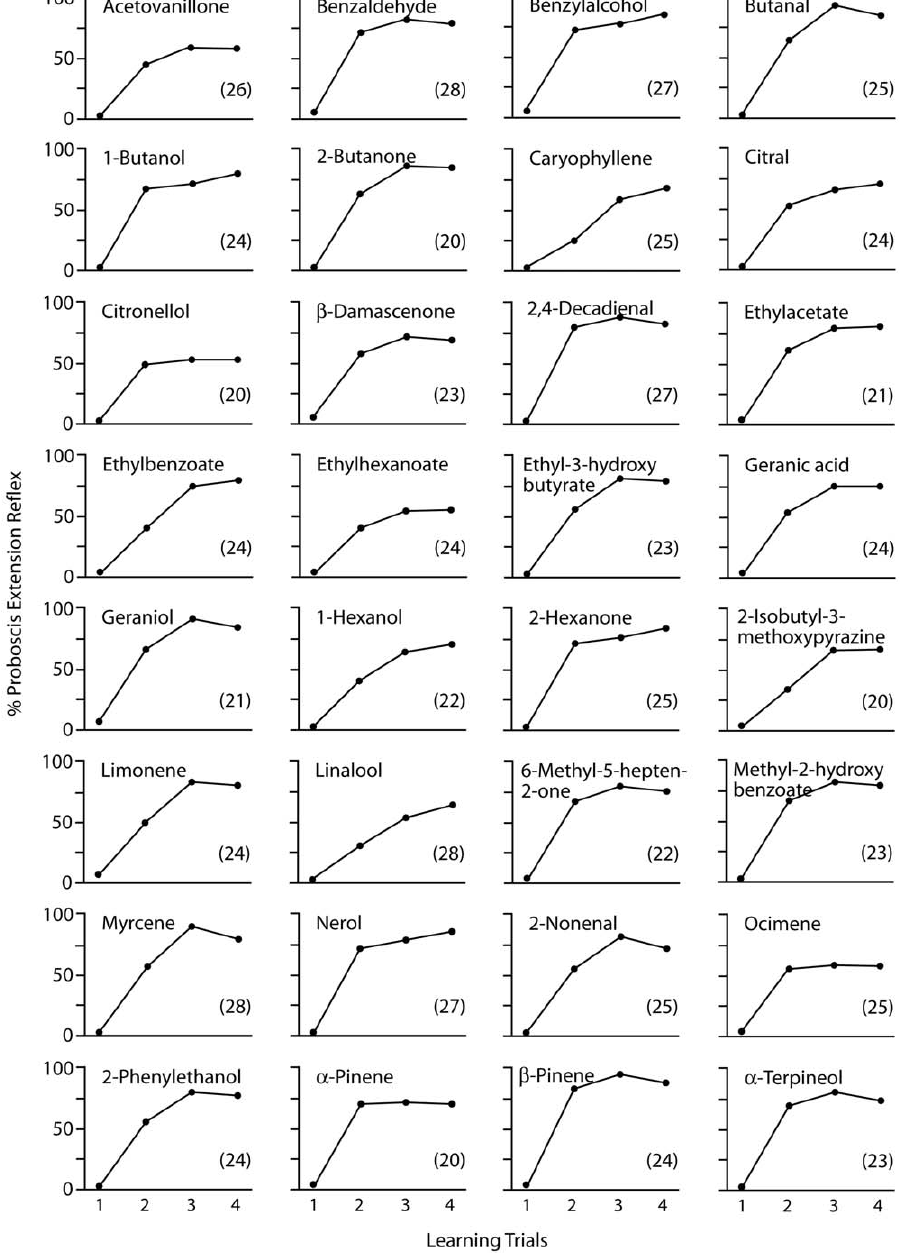
Figure 1. Acquisition Curves for 32 Floral Odorants. The ordinate represents the percentage of proboscis extensions (PER) to the training odorant. The abscissa indicates the training trials spaced over two days, three trials on day one and a fourth trial on day two. The numbers in brackets indicate the numbers of bees trained for each odorant. Odorants are listed alphabetically, for physico-chemical characteristics of odorants see Table 1.